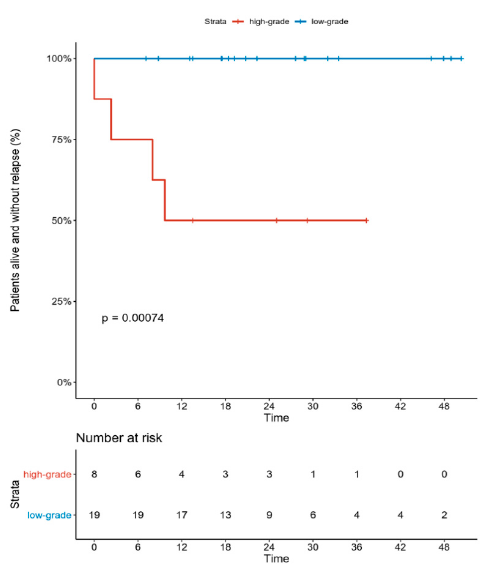
Figure 1. DFS (disease-free survival) according to tumor grade.